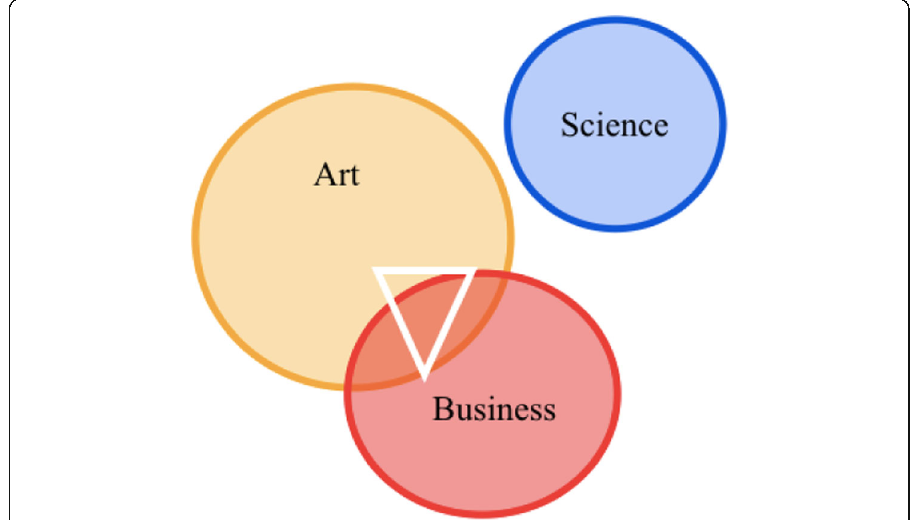
Fig. 3 Model of the Intersection of Art, Science and Business applied to Contemporary Art Museums. ©